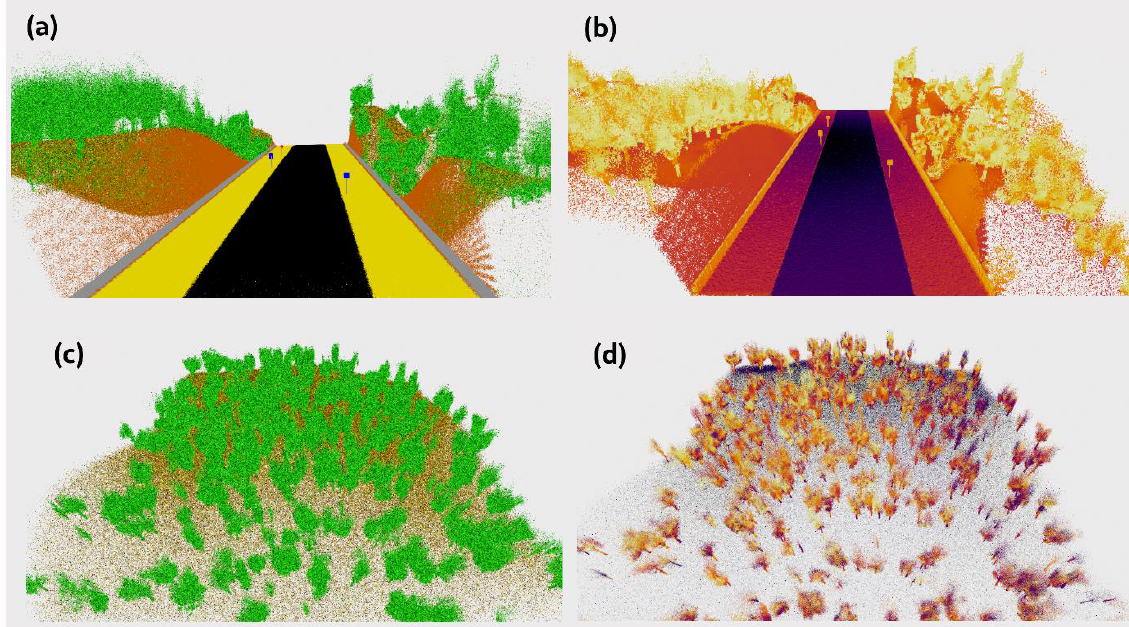
Figure 6. (a,b) Local road point cloud colored by labels and Pr/C values at 900 nm of wavelenght and (c,d) generic forest point cloud colored by labels and Pr/C values at 900 nm of wavelenght,